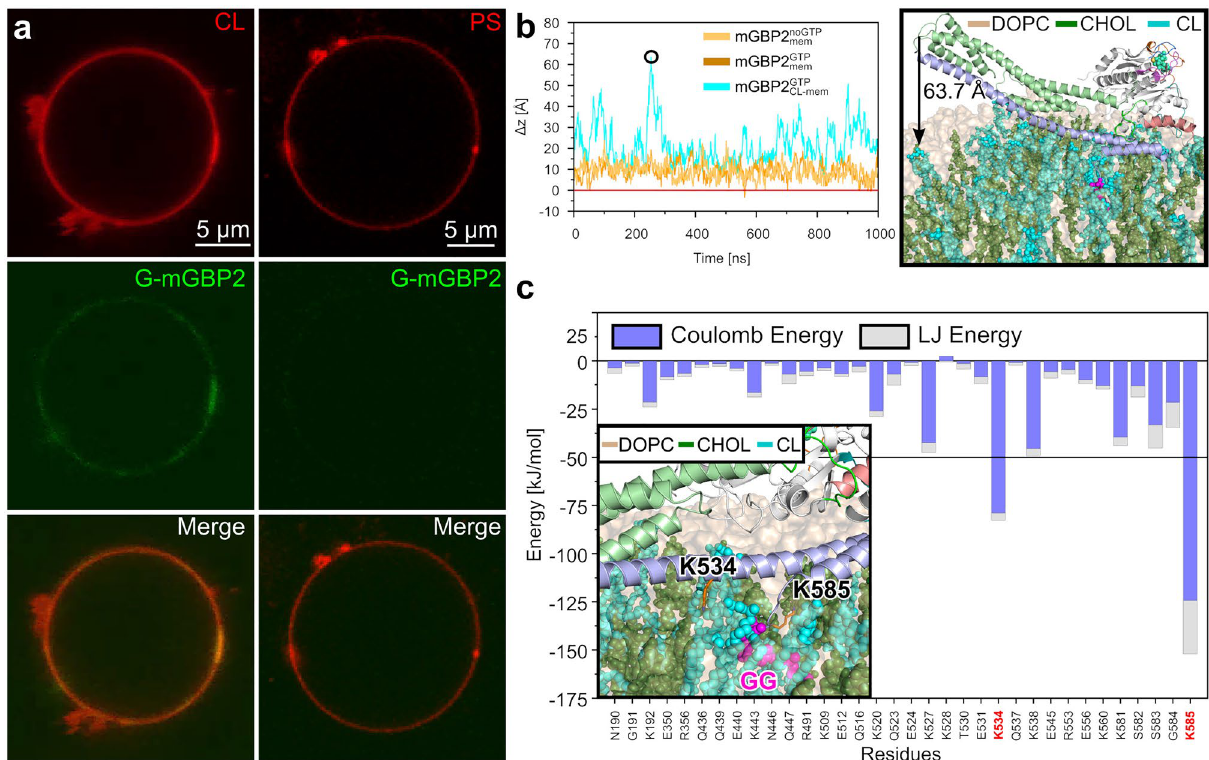
Figure 8. The binding of mGBP2 to mixed lipid membranes. ( a ) GFP-tagged mGBP2 accumulates at TexasRed- labeled GUVs containing cardiolipin (CL, left) but not at GUVs with phosphatidylserine (PS, right). ( b ) Simulations of mGBP2 bound to a DOPC/cholesterol/cardiolipin bilayer revealed large-scale motions of the M/E domain, as monitored by the distance ( (cid:31) z ) between residue L480 and the average position of the lipid head groups (red line). The results for the mGBP2 GTP CL-mem system (cyan) are compared with the motions found for mGBP2 GTP mem (brown) and mGBP2 noGTP mem (orange). The snapshot on the right shows the conformation with the largest movement of the M/E domain ( (cid:31) z = 63.7 Å), where the lipids are colored in ochre for DOPC,